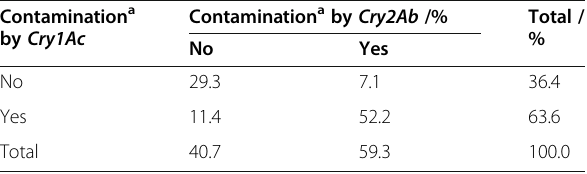
Table 2 Contamination status of conventional seeds in samples from conventional cotton fields (% of 297